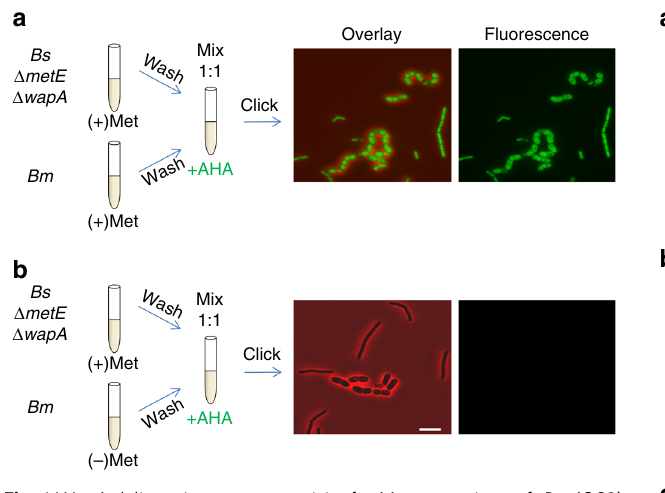
Fig. 6 WapA delivery is not a prerequisite for Met extraction. a , b Bm (OS2) was grown over night in S7 medium in the presence ( a ) or the absence ( b ) of Met (50 μ g/ml). Cells were then washed in PBSx1, mixed with Bs (OS25: Δ metE , Δ wapA ) and resuspended in S7 supplemented with AHA (1 mM). Cells were incubated for additional 1.5 h, underwent click reaction and visualized by fl uorescence microscopy. Shown are overlay images of fl uorescence from AHA ( green ) and phase contrast ( red ; left panels ), and AHA fl uorescence alone ( right panels ). Scale bar represents 5 µ m